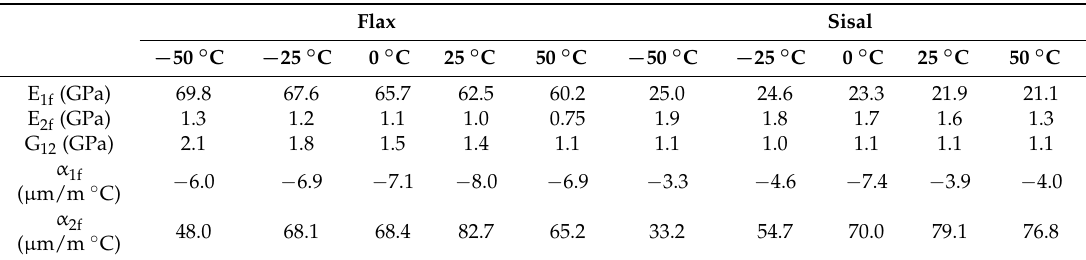
Table 1. Summary of flax and sisal fibre thermoelastic properties at different temperatures. Flax